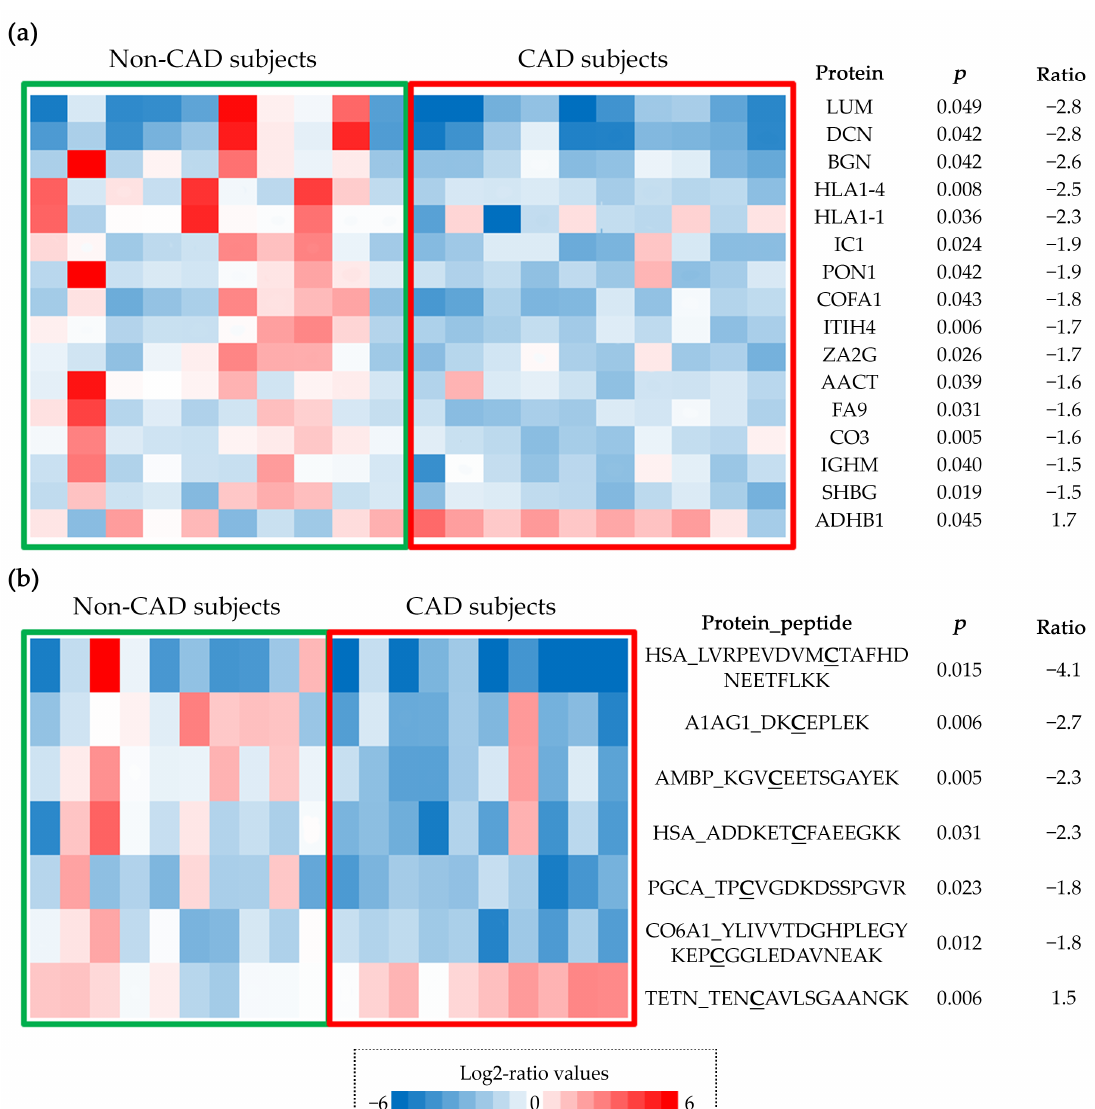
Figure 2. Proteins and oxidized peptides with differences in abundance between groups. Log2-ratio values are represented in a color scale (red means higher levels and blue lower levels); ( a ) heat-map representing abundance changes in differentially expressed proteins. Protein abbreviation, p -value and Zq log2-ratios are shown; ( b ) heat-map representing abundance changes in oxidized peptides. Protein abbreviation, measured peptide, p -value and Zp log2-ratios are shown. OxCys are bold and underlined. CAD, coronary artery disease.